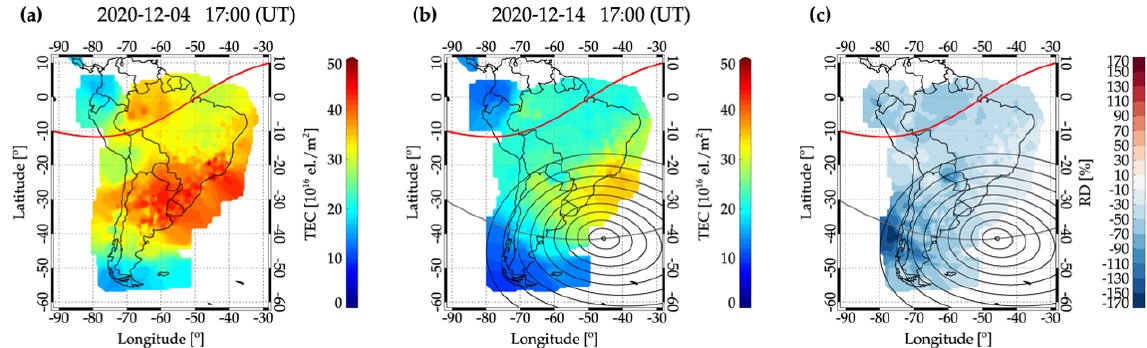
Figure 7. Longitude versus latitude distribution of the TEC map over South America (a) during the reference period (4 December 2020, at 17:00UT), (b) during the solar eclipse event (14 December 2020, at 17:00UT), and (c) the RD parameter. The red line refers to the magnetic equator, the circular lines refer to the eclipse area, and the color scale indicates the TEC